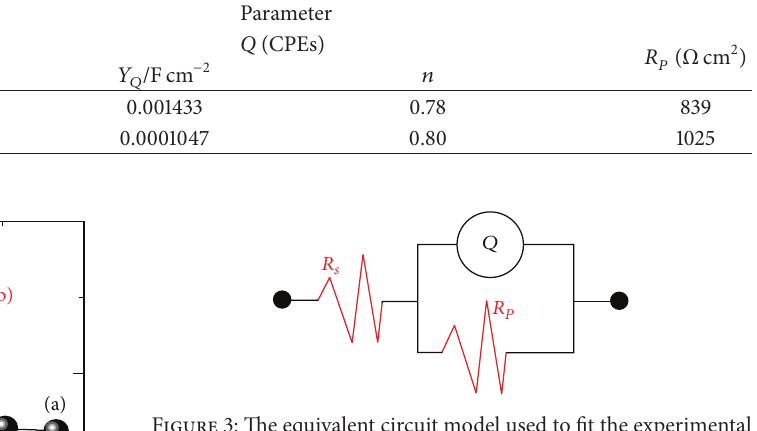
Figure 3: The equivalent circuit model used to fit the experimental data presented by Nyquist plots shown in Figure 2; symbols of the circuit are defined in the text.